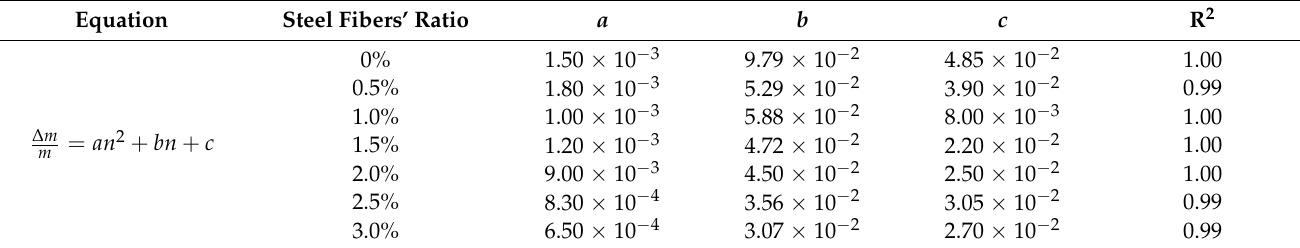
Figure 13. Mass loss rate of steel bars reinforced MPC-RPC during NaCl D-W alternations. Table 7. The fitting results of the relationship between ( Δ m / m ) and n .